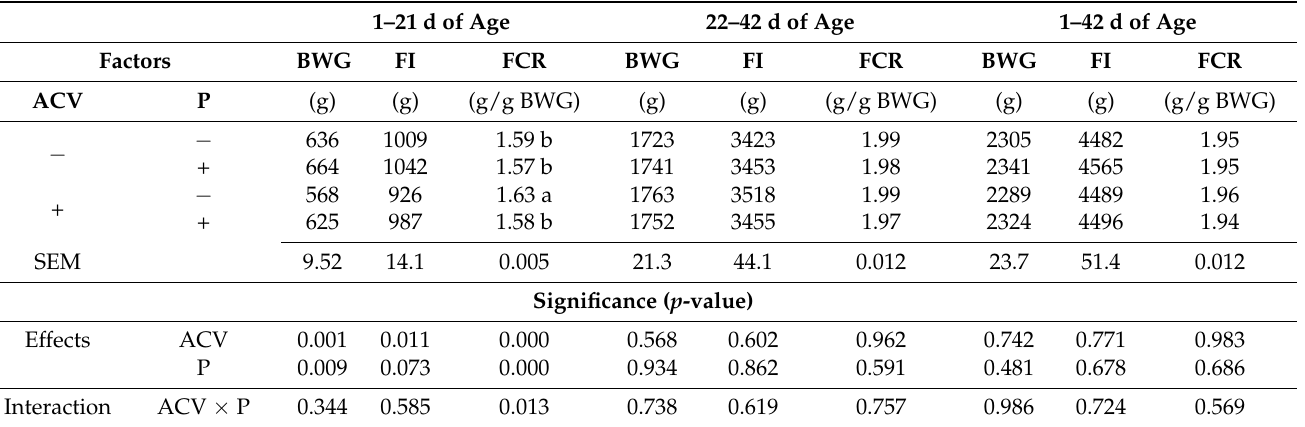
Table 2. Effects of the experimental factors on the performance in the starter (1–21 d) and grower- finisher (21–42 d) feeding phases and the entire experimental period (1–42 d).